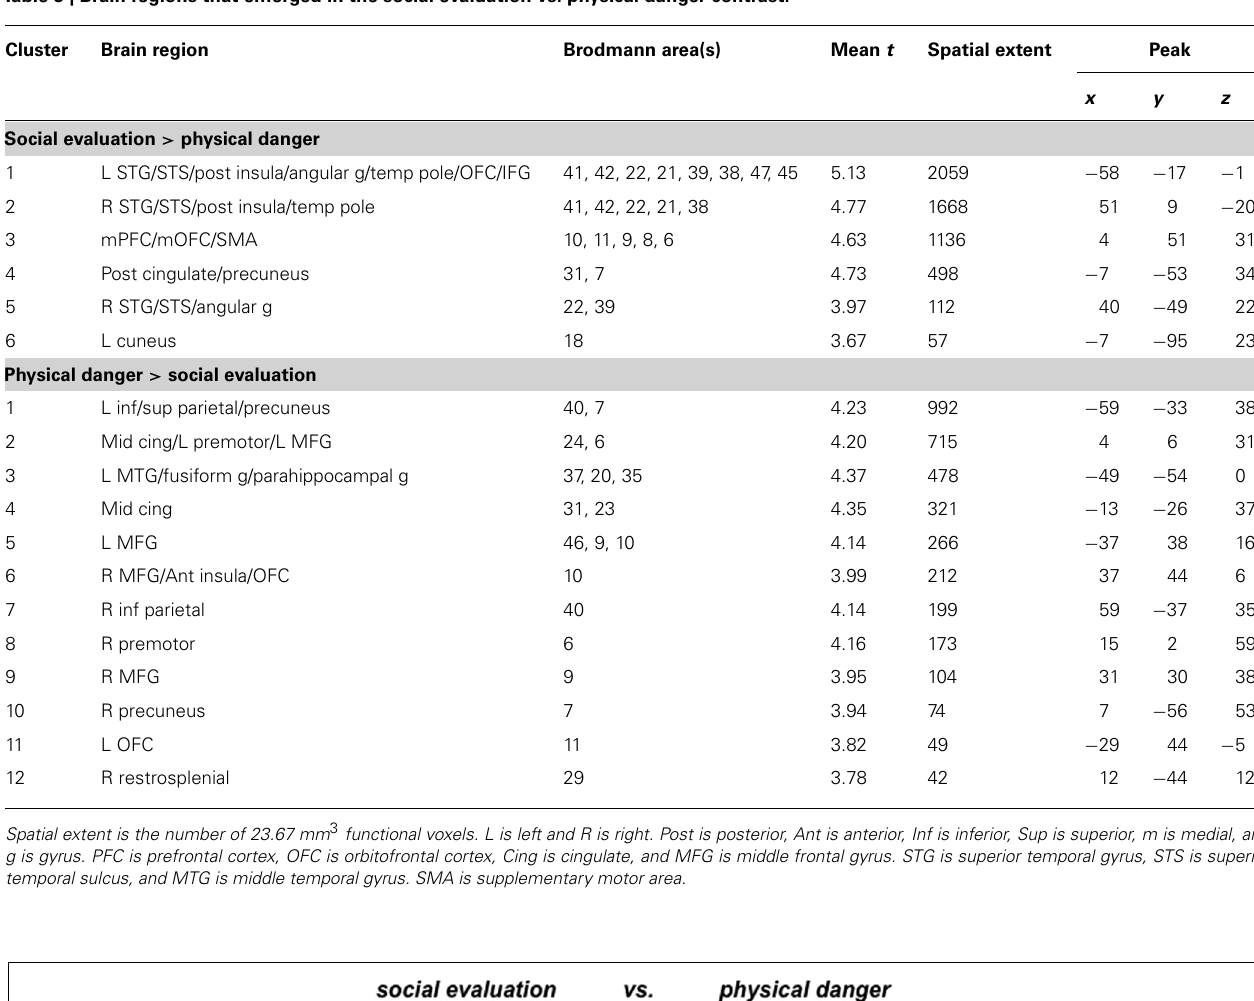
Table 3 | Brain regions that emerged in the social evaluation vs. physical danger contrast.